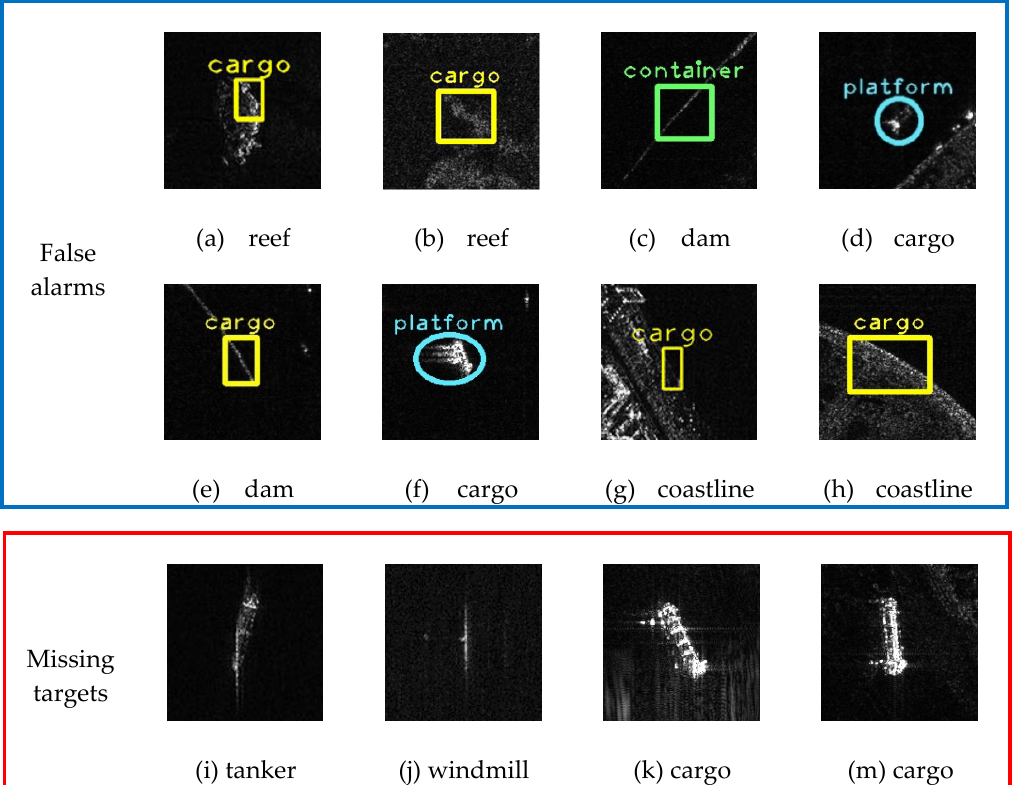
Figure 10 . Samples of false alarms and missing targets. The ground truths of the patches:( a ) Reef; ( b )